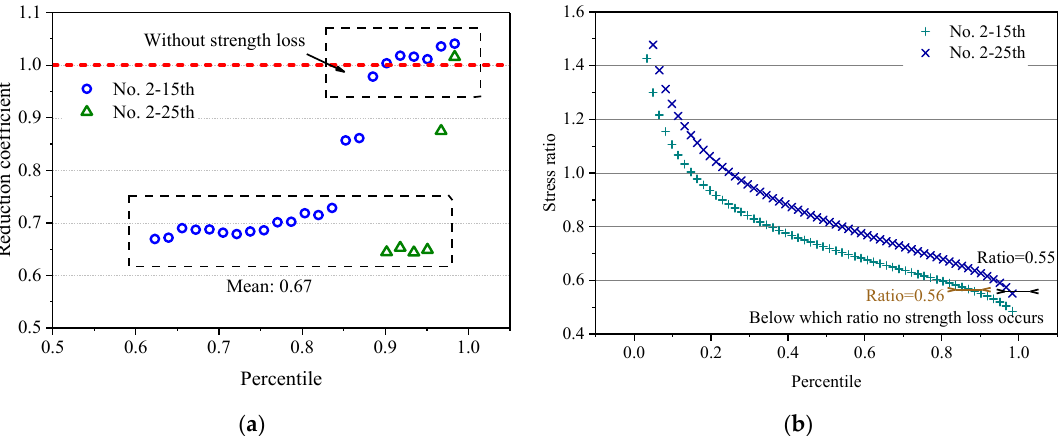
Figure 7. Test results of Grade No. 2 dimension lumber. ( a ) Strength reduction coefficient of the survivals, ( b ) Stress ratios of all specimens.